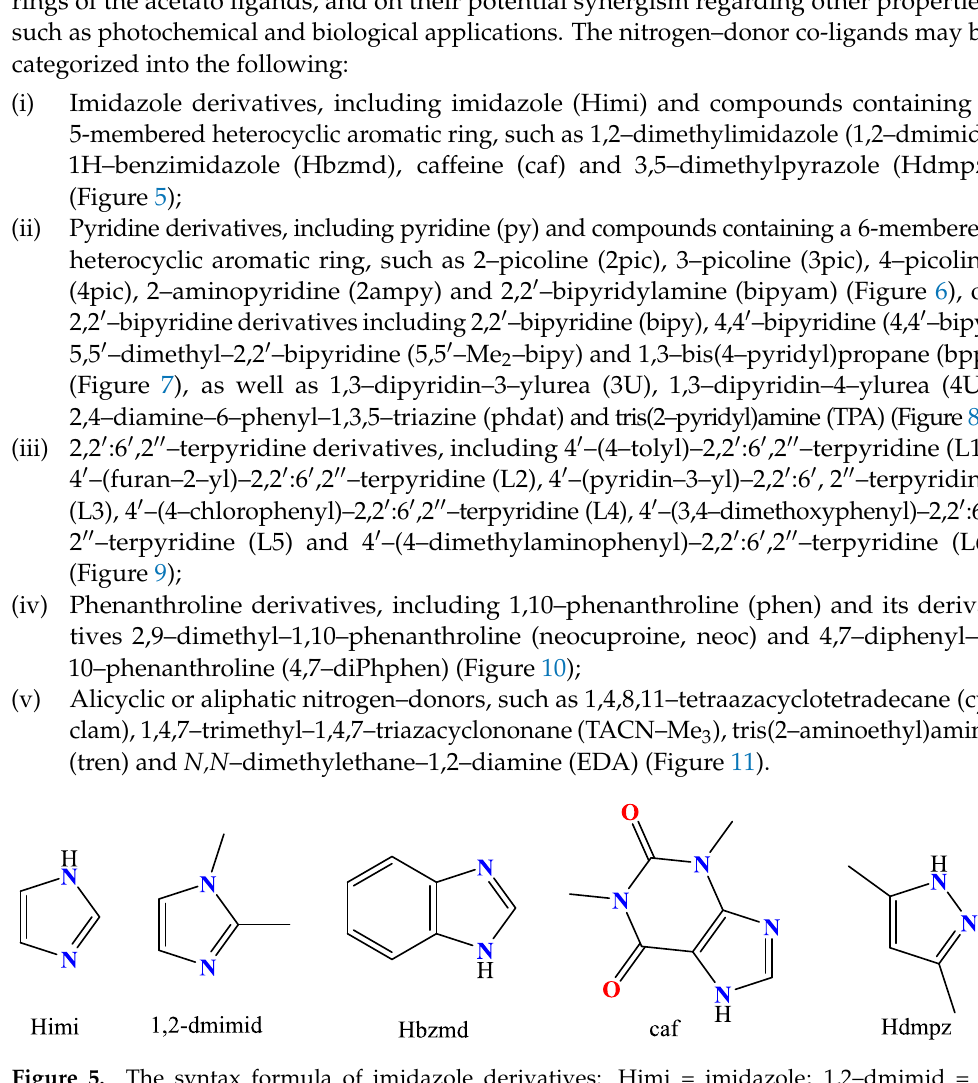
Figure 5. The syntax formula of imidazole derivatives: Himi = imidazole; 1,2–dmimid = 1,2–dimethylimidazole; Hbzmd = 1H–benzimidazole; caf = caffeine and Hdmpz = 3,5–dimethylpyrazole.